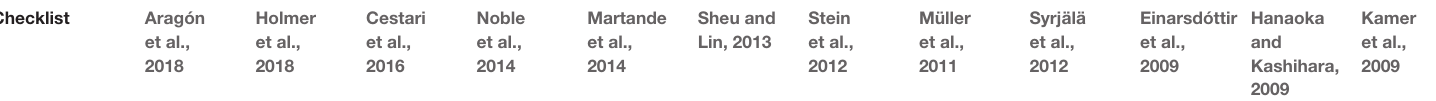
TABLE 2 | Risk of bias assessment of the included